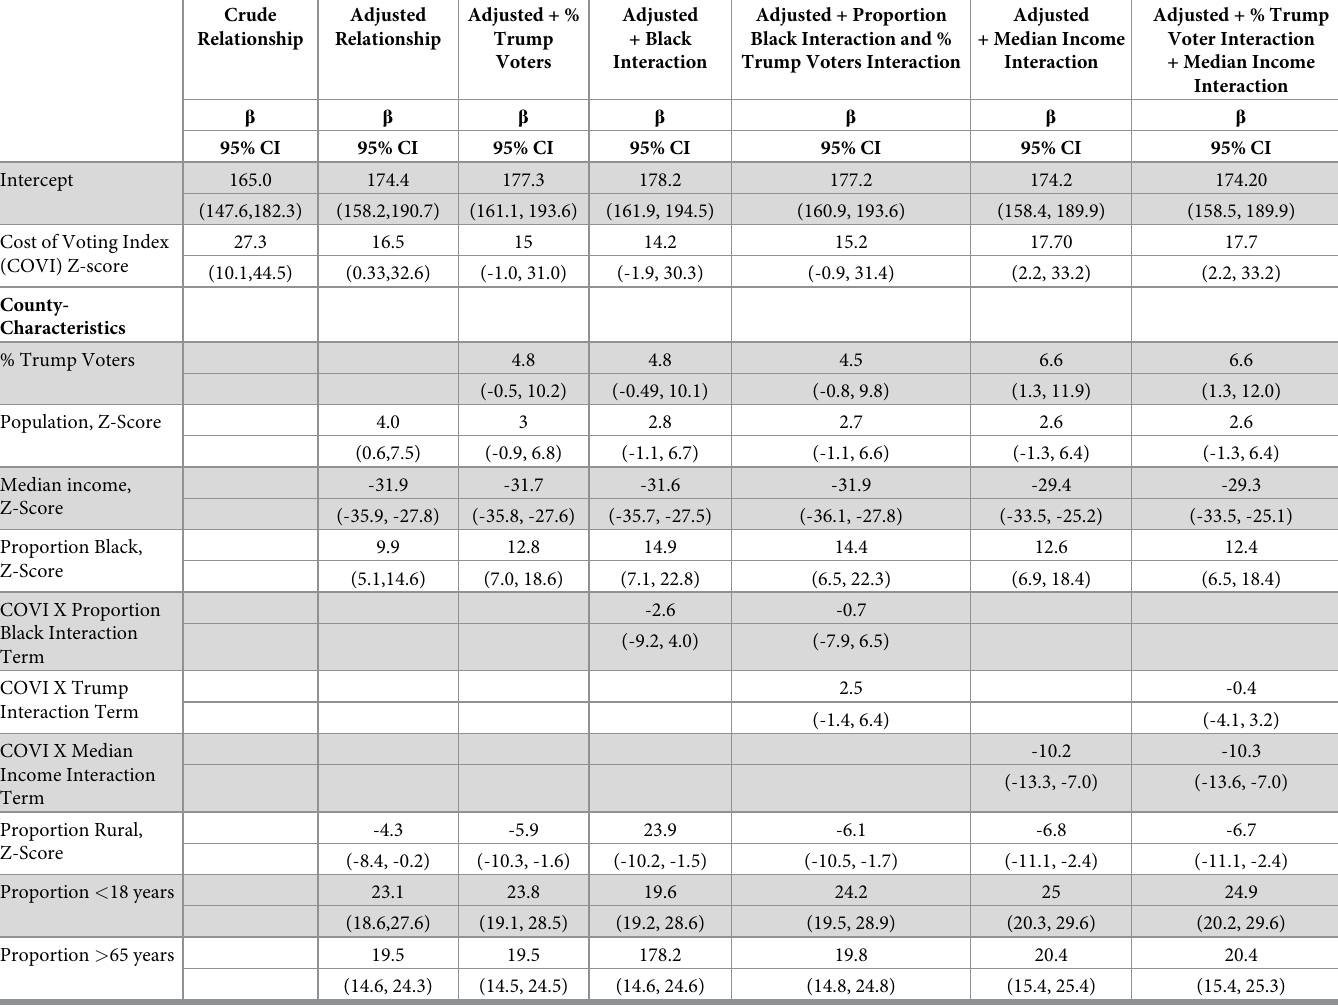
Table 3. The relationship between Cost of Voting Index and COVID-19 death rate during the first year of the pandemic. Crude